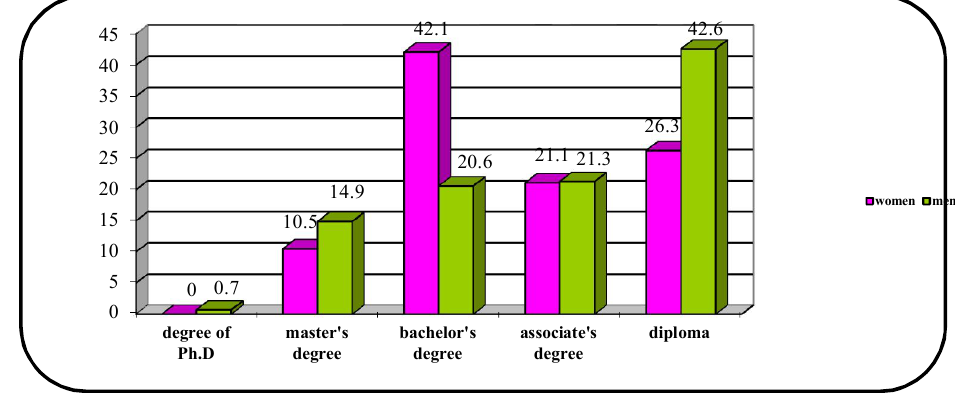
Fig. 3. The percentage of subjects in terms of education